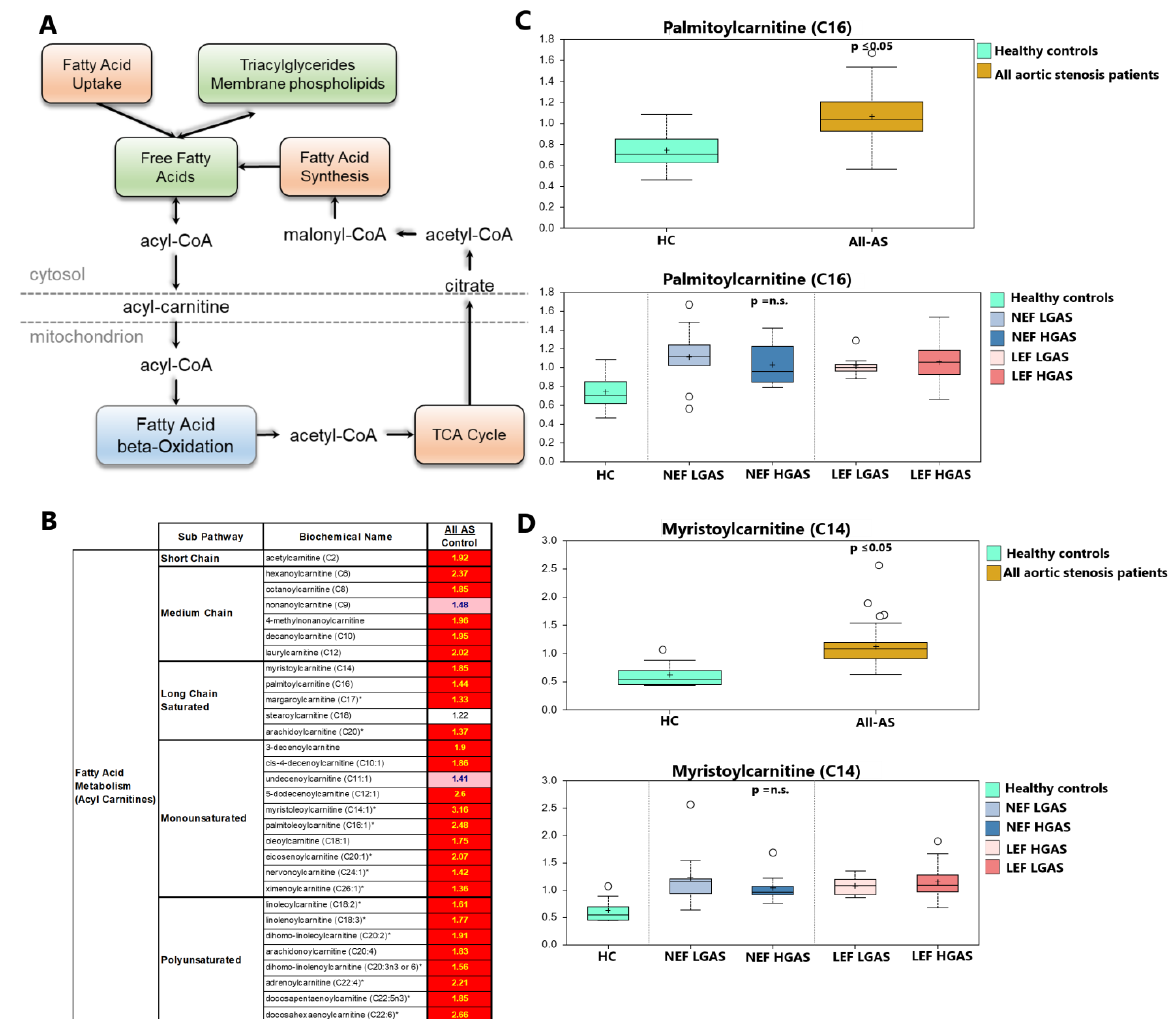
Figure 3. Altered metabolism of fatty acids. ( A ) Illustration of fatty acid uptake to the mitochondria by transfer of acyl-residues to acylcarnitine. ( B ) List of altered aclycarnitines between AS patients and healthy controls (significantly regulated molecules marked in red) Values marked in light red indicate a trend towards statistical significance (0.05 < p < 0.10). Non-colored values are not significantly different for that comparison. Numbers indicate x-fold increase in concentration. * p ≤ 0.05. ( C , D ) Palmitoylcarnitine (C16) and myristoylcarnitine (C14) as examples between All-AS vs controls as well as the different AS subgroups. On each box, the black cross indicates the mean value, the borders and segmentation indicate limits of upper/lower quartile and median values. Outliers are plotted as circles. n.s.: not significant between AS subgroups.